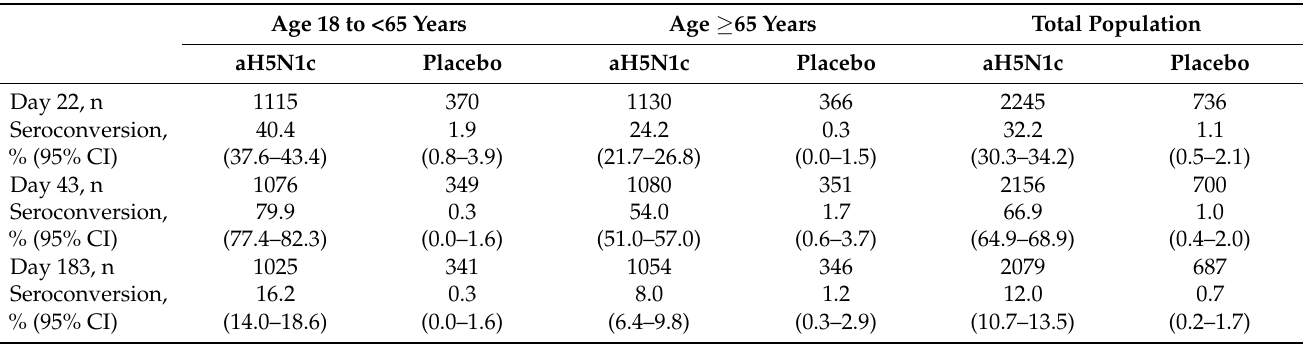
Table 3. Percentages of subjects (95% CI) achieving seroconversion in HI titer a